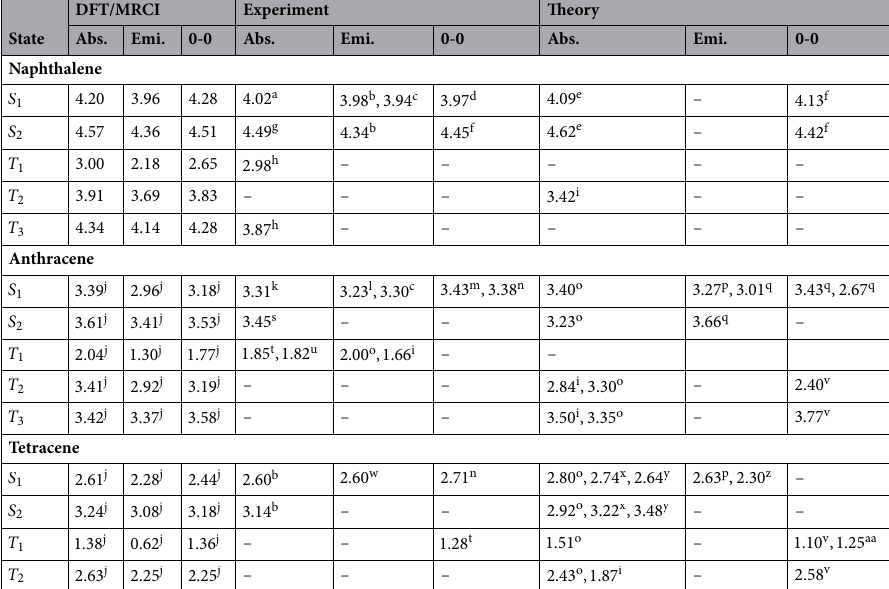
Table 1. Singlet and triplet energies for naphthalene, anthracene, and tetracene, compared to those found in literature, in eV. Given absorption (Abs.) and emission (Emi.) energies are vertical excitation energies from the ground state, while adiabatic energies are presented here as 0-0 transitions. A “–” indicates that the information could not be found. a From Ref. 40 in the vapour phase. b From Ref. 41 using cyclohexane. c From Ref. 42 using cyclohexane. d From Ref. 43 in the vapour phase. e From Ref. 39 using MRMP/cc-pVDZ. f From Ref. 44 using CC2/TZVPP. g From Ref. 45 using n-hexone. h From Ref. 46 using CNDO/S-CI. i From Ref. 47 using CI. j From Ref. 10 using DFT/MRCI. k From Ref. 48 using h-heptane. l From Ref. 49 using chlorobenzene m From Ref. 50 in the vapour phase. n From Ref. 51 in the gas phase. o From Ref. 52 using MRMP/cc-pVDZ. p From Ref. 53 using SCFMO. q From Ref. 54 using SAC-CI(SD-R)/6-31G(d,p). r From Ref. 55 using PBE/TZP. s From Ref. 56 using cyclohexane. t From Ref. 57 . u From Ref. 58 in ammonia. v From Ref. 59 in alcohol. w From Ref. 60 using toluene. x From Ref. 61 using DFT/MRCI/TZVP. y From Ref. 62 using B3LYP/ANO-S-VDZP. z From Ref. 63 using RAS- 2SF/6-31G*. aa From Ref. 64 in the vapour phase.